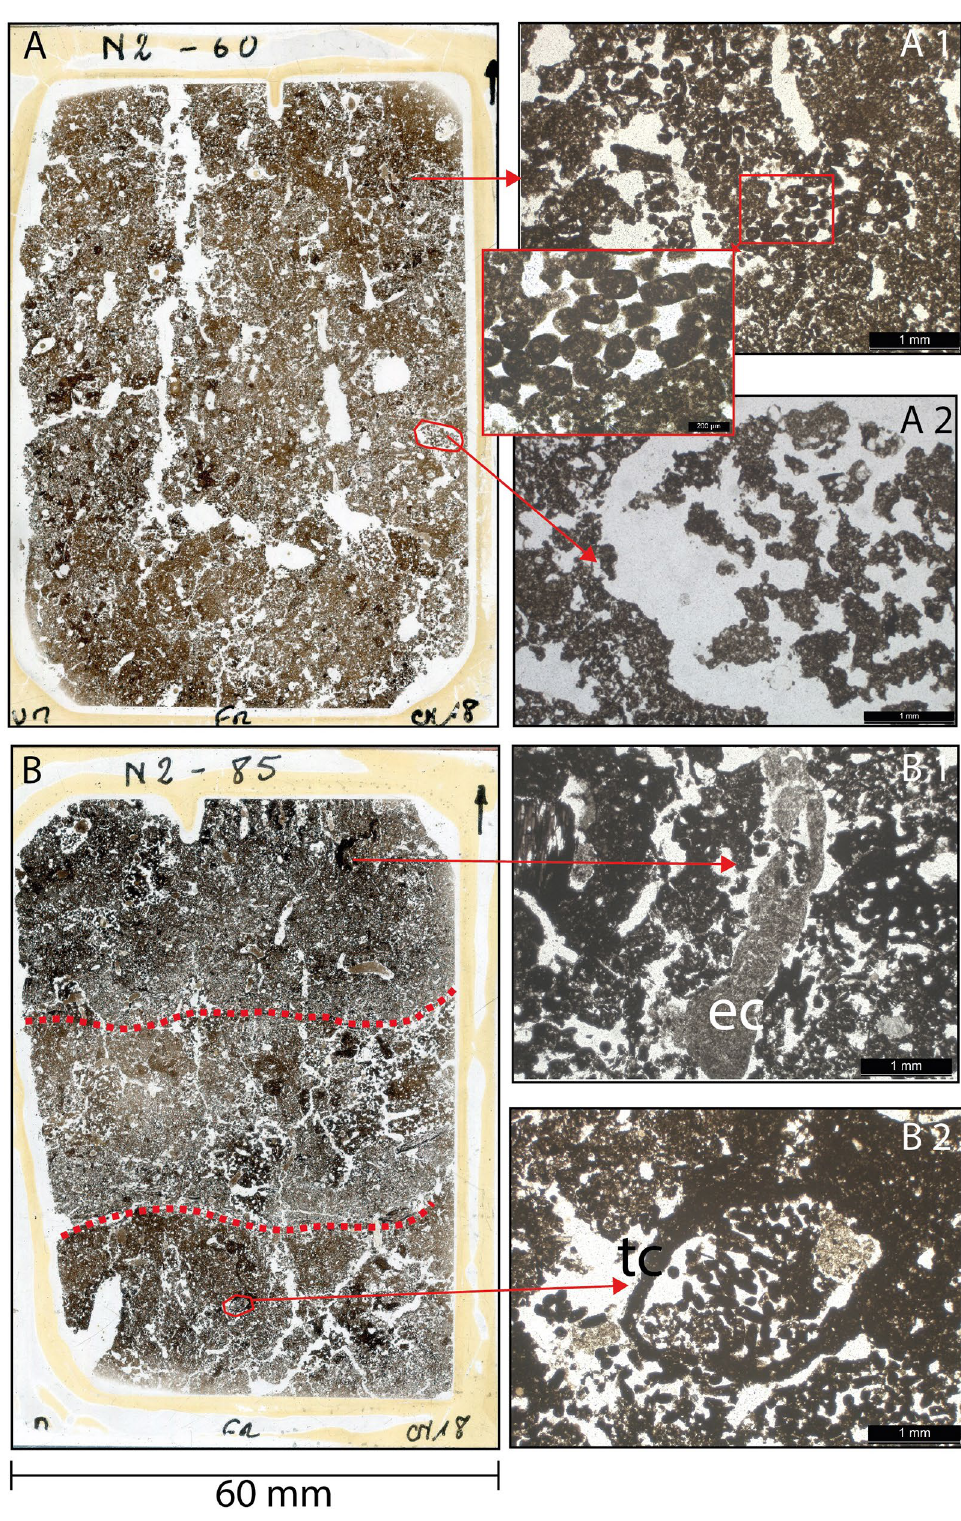
Figure 5. Scans and photomicrographs [plain polarized light (PPL)] from thin sections of field N2 illustrating the alteration of RF soils by biota. (A) Thin section from 60 cm depth, a mixed organo-mineral layer with large bio-pores and root channels infilled with faunal excrements. (A1) Soil structure made from bacillo-cylindric faunal excrements. (A2) Soil pore filled with degraded faunal excrements. B: Thin section from 85 cm depth encompassing three distinct layers (organic-mineral-organic) with boundaries (dashed red lines) blurred by mixing. (B1) Earthworm excrements (ec). (B2) Channel built by termites/ants (tc) infilled with bacillo-cylindric faunal excrements, most probably produced by small annelids (Enchytraeidae) or mites. Thin sections were analyzed with a Leica DMLP 2000 microscope. For complete documentation of micromorphology, see